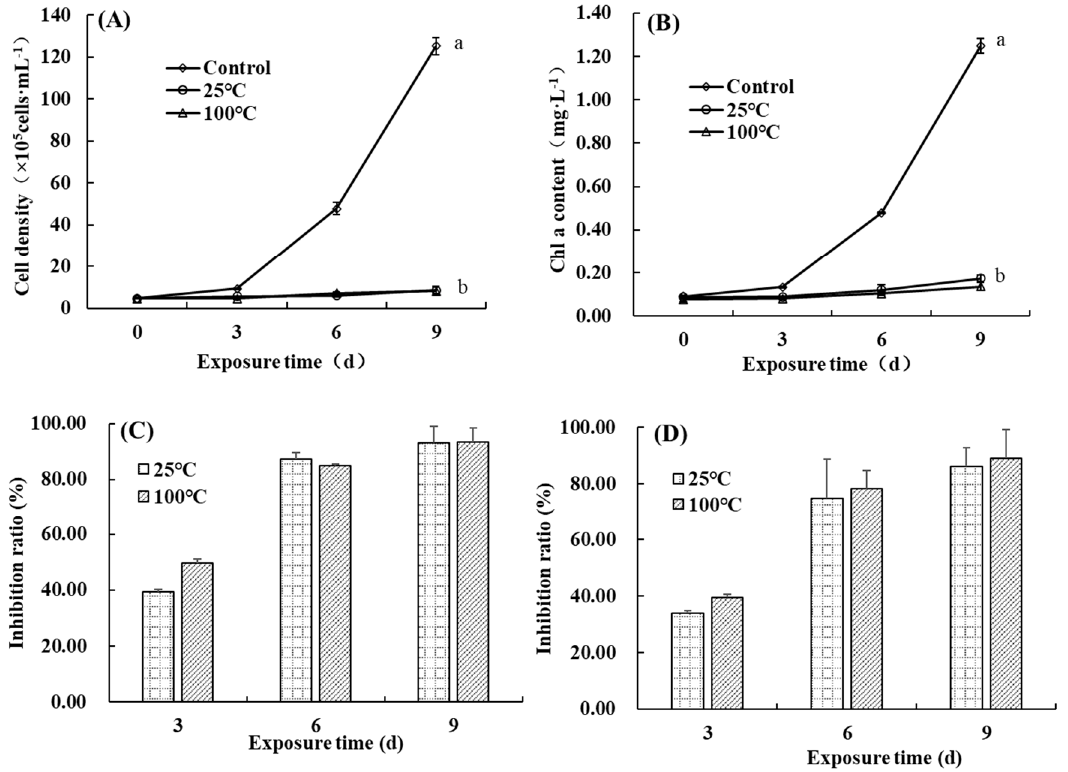
Figure 3. Cell density ( A ) and chl a content ( B ) of M. aeruginosa in response to water-soluble substances extracted from D. indicum flowers at 2.0 g·DW·L − 1 with normal temperature water (25 °C) and boiling water (100 °C), and the corresponding inhibition ratio in terms of cell density ( C ) and chl a content ( D ) in a 9-day bioassay. Different letters indicate significant differences among different groups at p < 0.05 level.